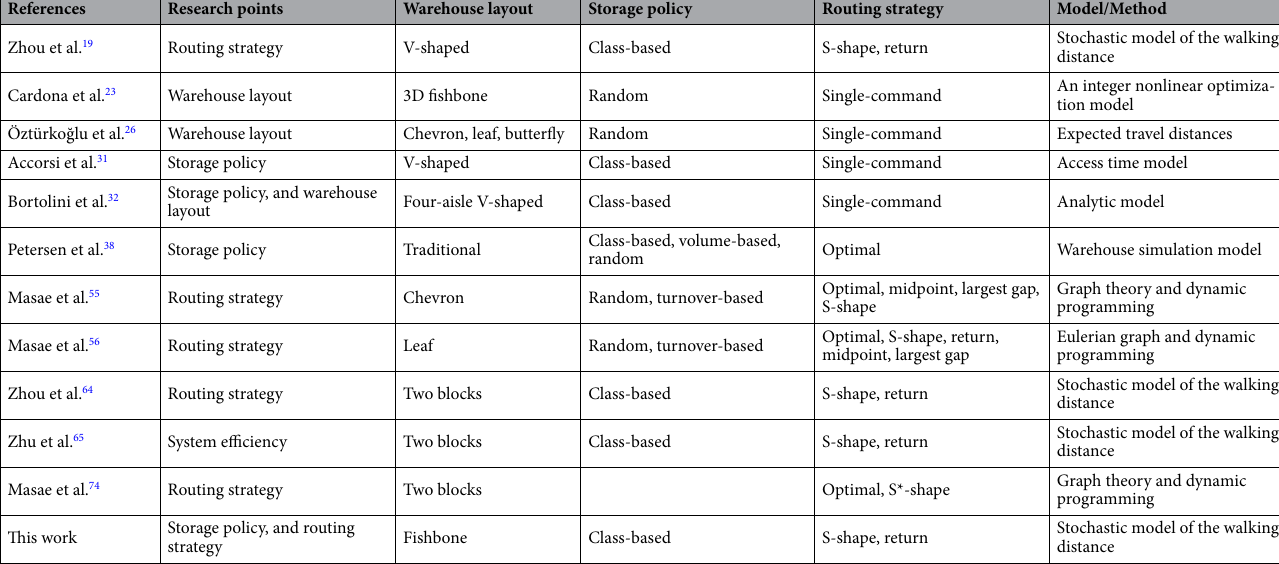
Table 1. Comparison with the existing